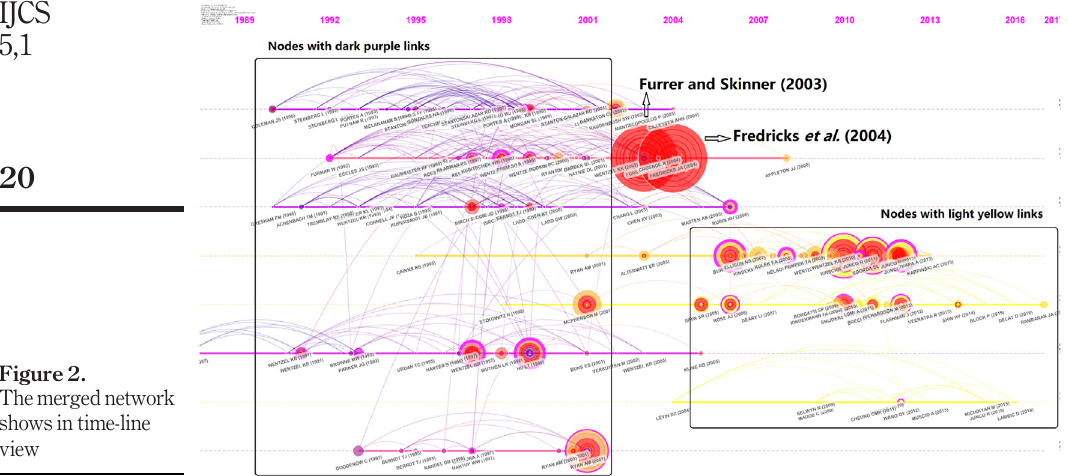
Figure 2. The merged network shows in time-line